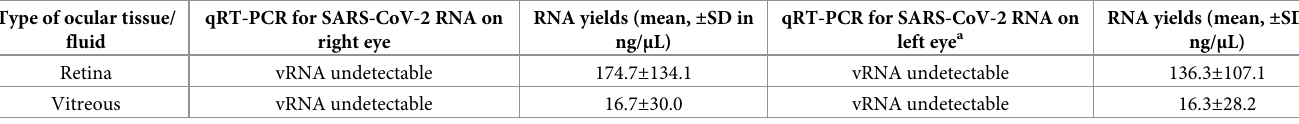
RNA yields (mean, ± SD in ng/ μ L)